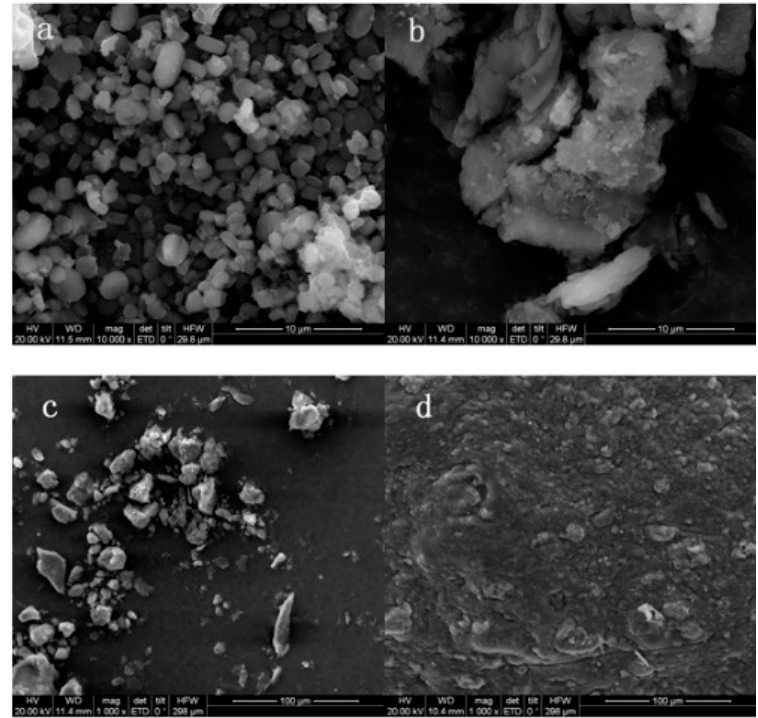
Figure 1. SEM pictures of ( a ) MIL-125(Ti), ( b , c ) MIL-125-CS and ( d ) MIL-125-CS-Pb.